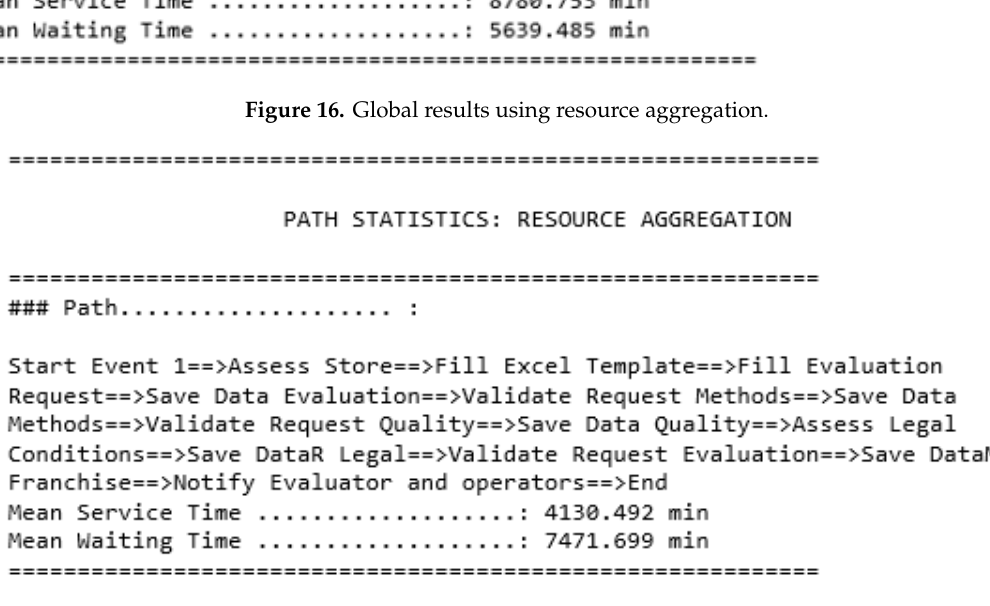
Figure 17. Global results for inexperienced human resource after removing the “Check Legal conditions” step.